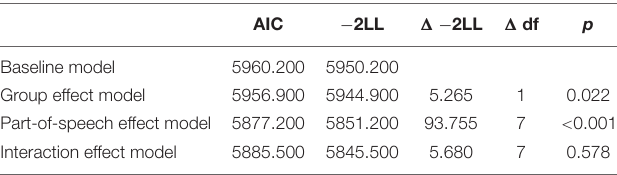
TABLE 6 | Comparison of the baseline, the group effect, the part-of-speech effect TABLE 7 | Estimates of fixed effects for effects of task, typing speed and group on and the interaction effect models for pause time between words. time on task and number of characters per minute. AIC